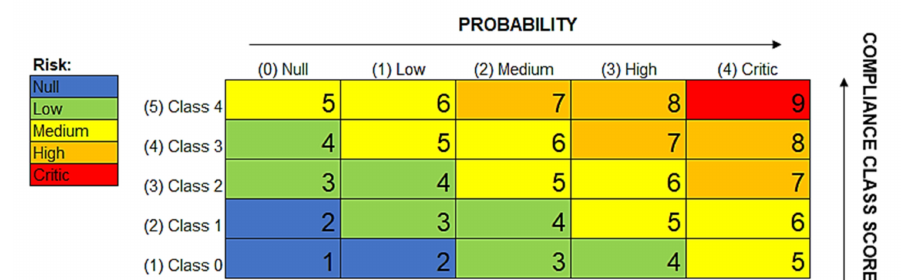
Figure 7. Risk and impact matrix.